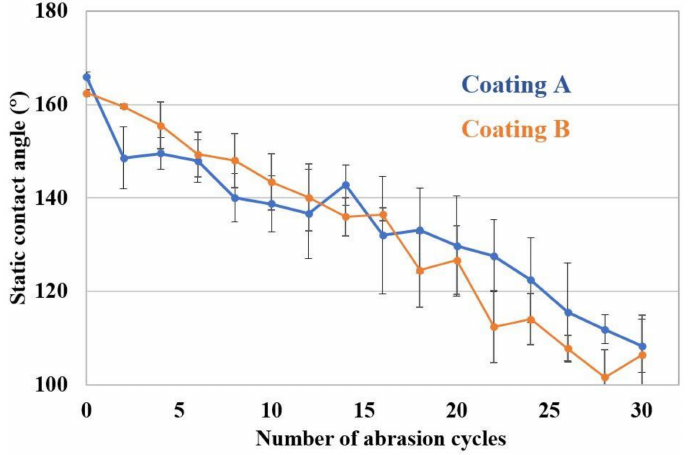
Figure 10. Static contact angles after Taber abrasion test against 29.9 kPa normal load.